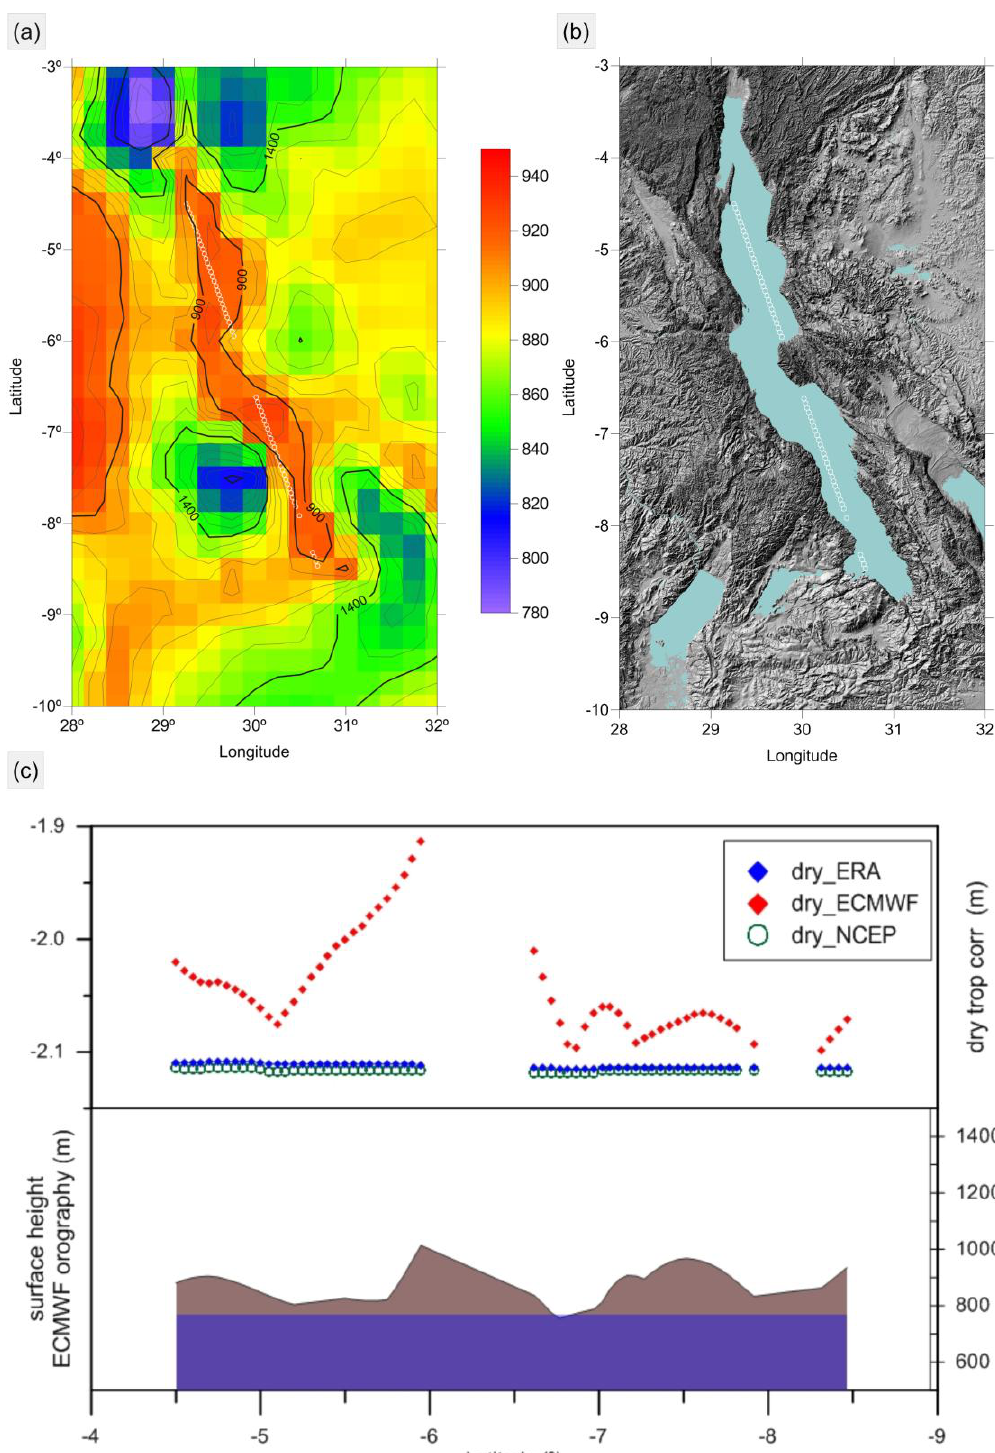
Figure 4. Illustration of dry tropospheric correction (DTC) errors for Jason-1 Pass 222 over Lake Tanganyika. ( a ) Pass location over ECMWF orography (contours, contour interval = 100 m) and surface pressure (color map, in hPa) of the closest in time ECMWF operational model grid; ( b ) Pass location over a DEM; ( c ) DTC ( top , m) for Pass 222, Cycle 62; the surface height from ECMWF orography ( bottom , in brown, m) and the lake level height above the EGM2008 geoid (as measured by Jason-1, in blue,